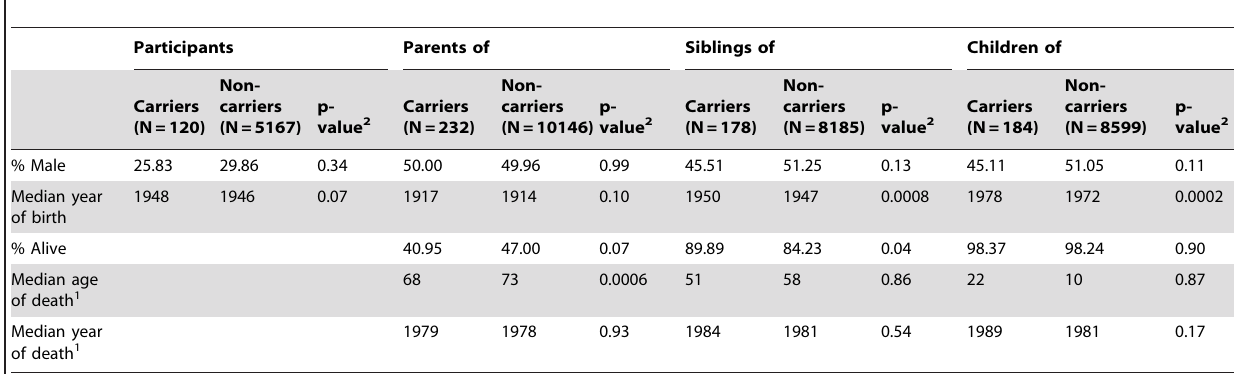
Table 1. Descriptive statistics for participants and first-degree relatives from the Washington Ashkenazi Study.